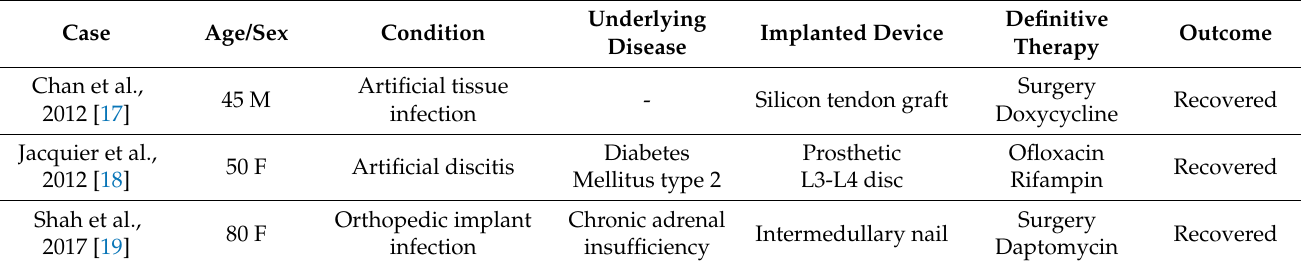
Table 4. Orthopedic